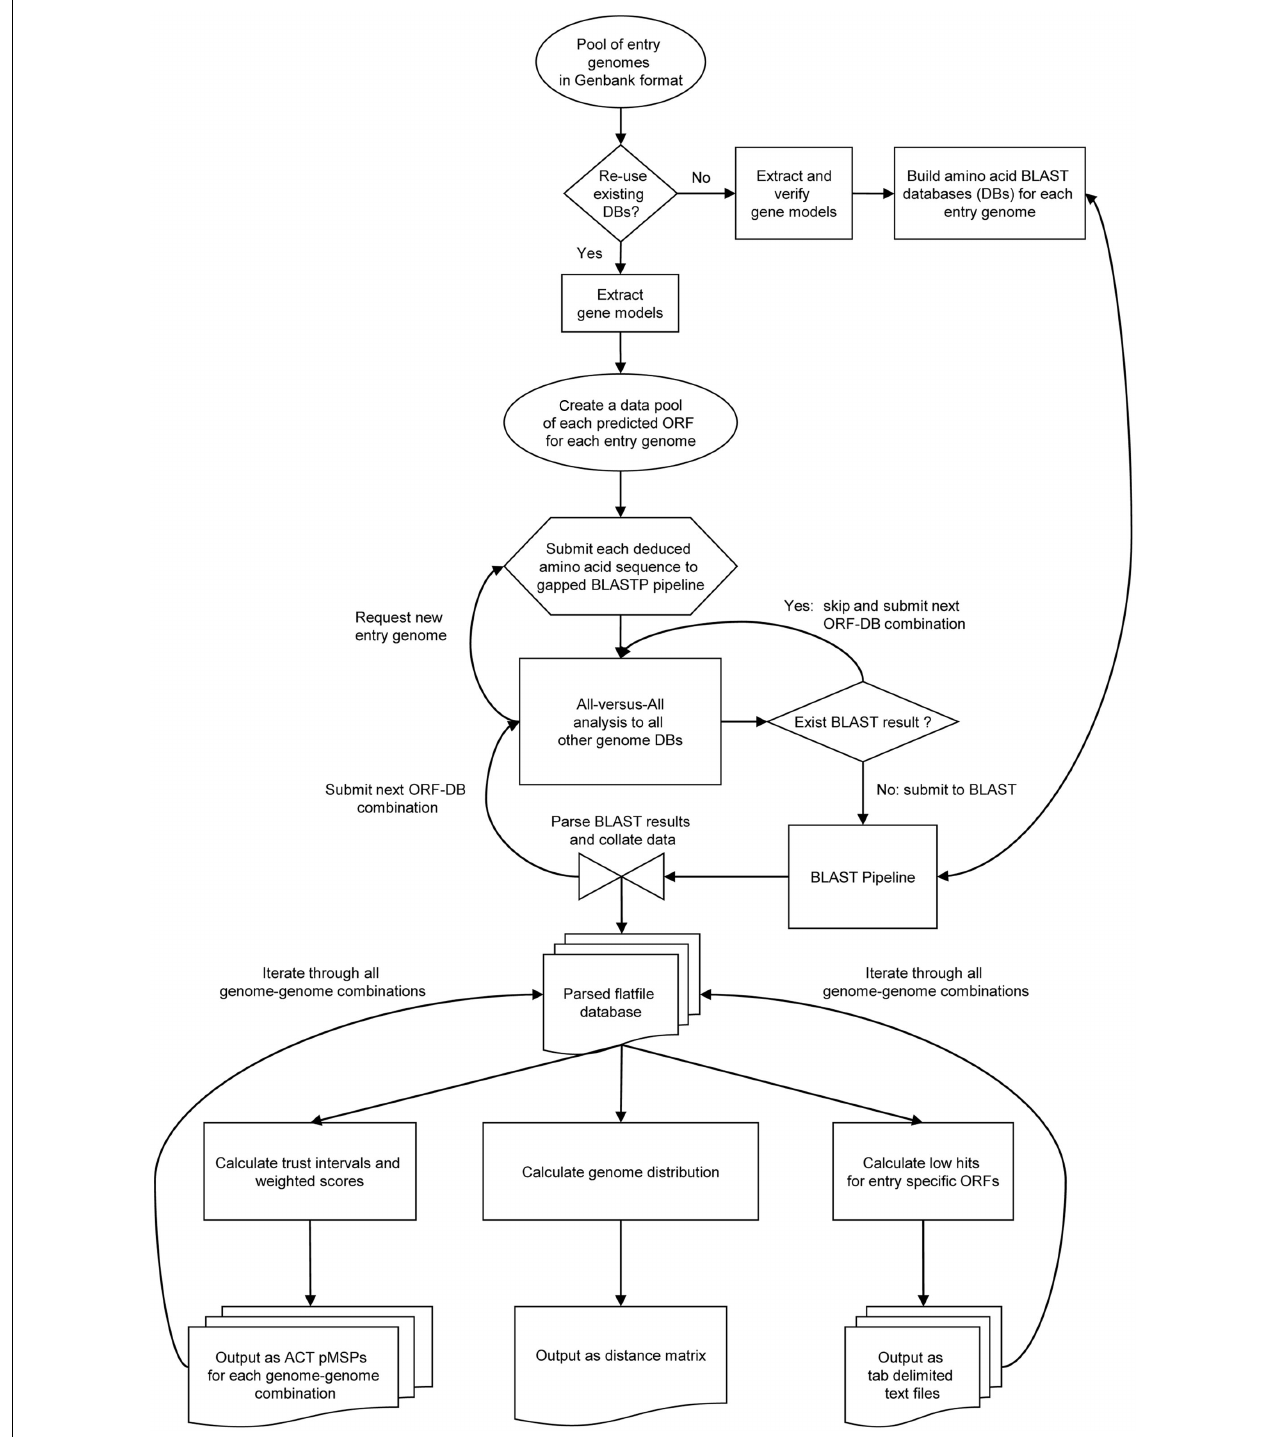
FIGURE 1 | Graphical workflow of the compACTor software. Schematic representation of the algorithm structure. Symbols used are consistent with standard flowchart icons. Abbreviations: DB, database; pMSPs, ORFeome based MSPcrunch comparison format (Sonnhammer and Durbin, 1994) data